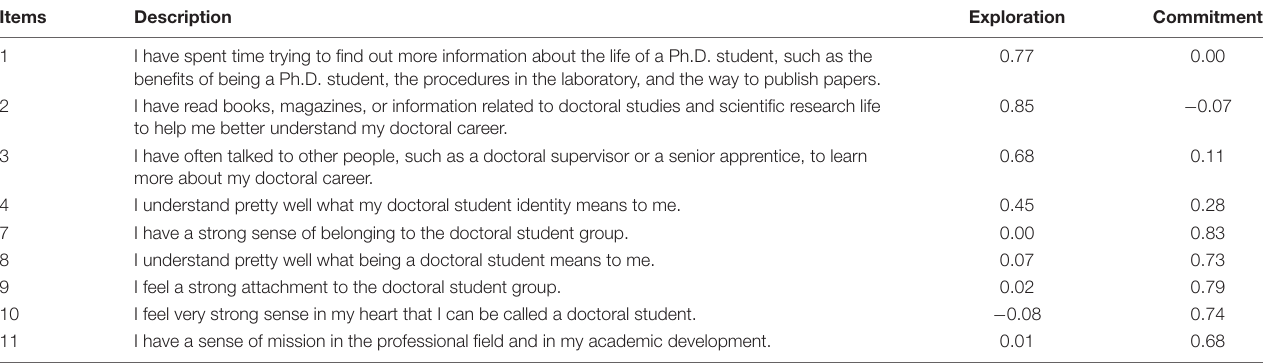
TABLE 6 | Exploratory factor analysis factor loadings for the two-factor model of the Doctoral Student Identity Scale ( n = 491). Items Description